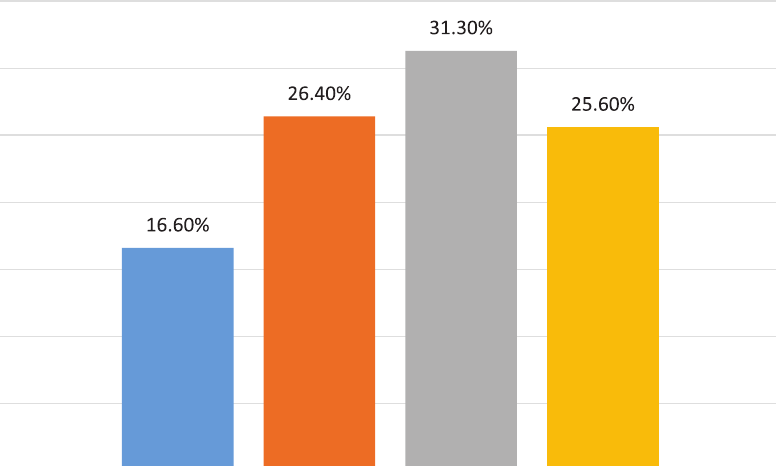
Figure 3. Vulnerability to disinformation concerning source credibility and confirmation bias. Notes: Blue stands for the statement “if you see a political news that your friend shared in social media you would probably like it and think is rele‐ vant”; orange for “if you see political news shared by a friend in social media, you would probably like it, comment, and share”; grey for “if you encounter news in social media that has a positive context for your affiliated political party, you would probably like it” is in grey; and yellow for “if you encounter news in social media that has a negative context for your affiliated political party, you would probably ignore it.”